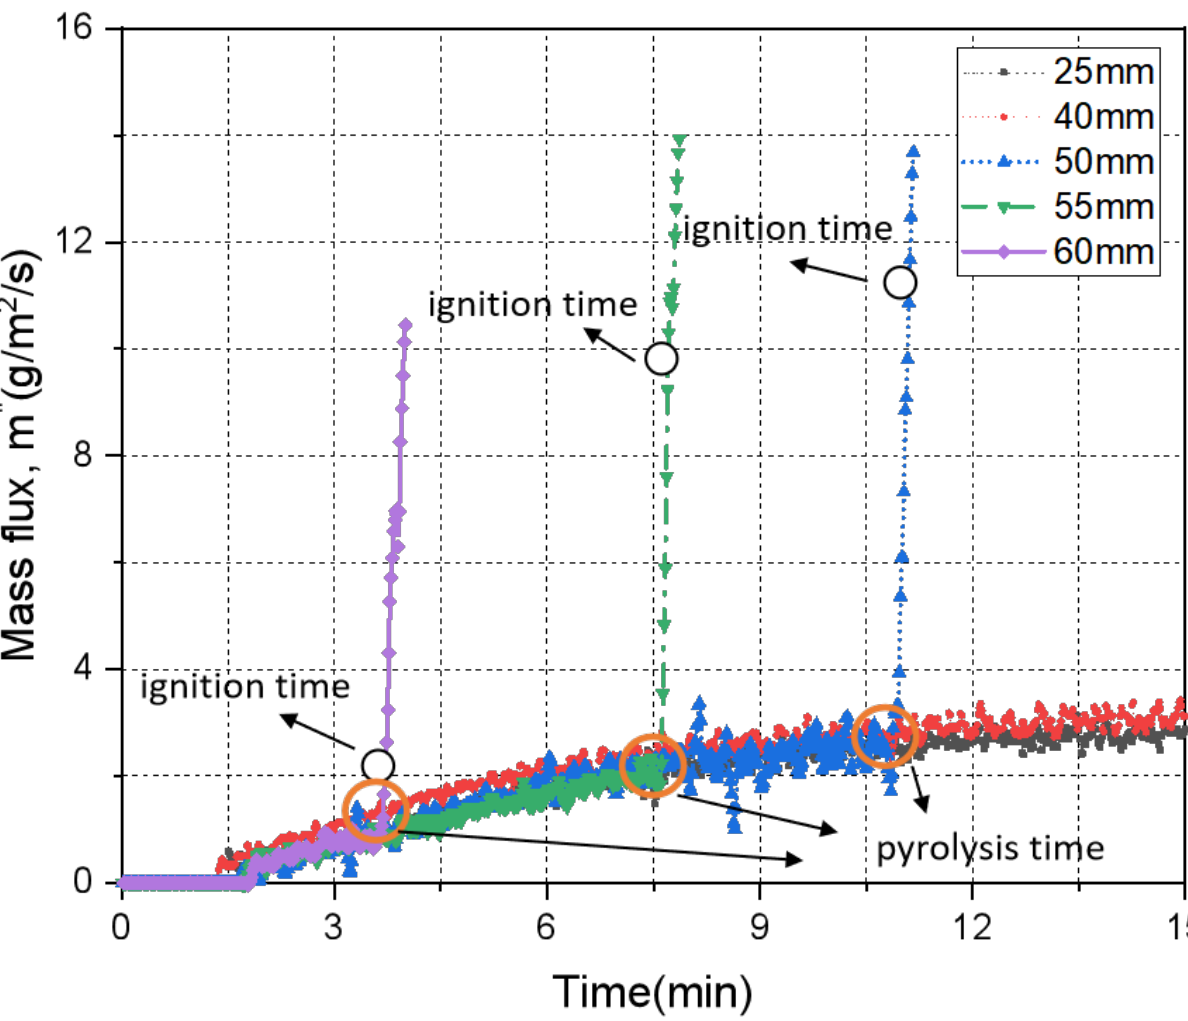
Figure 3. Time evolution of mass-flux difference in the ignition process of PMMA with different distances, D .